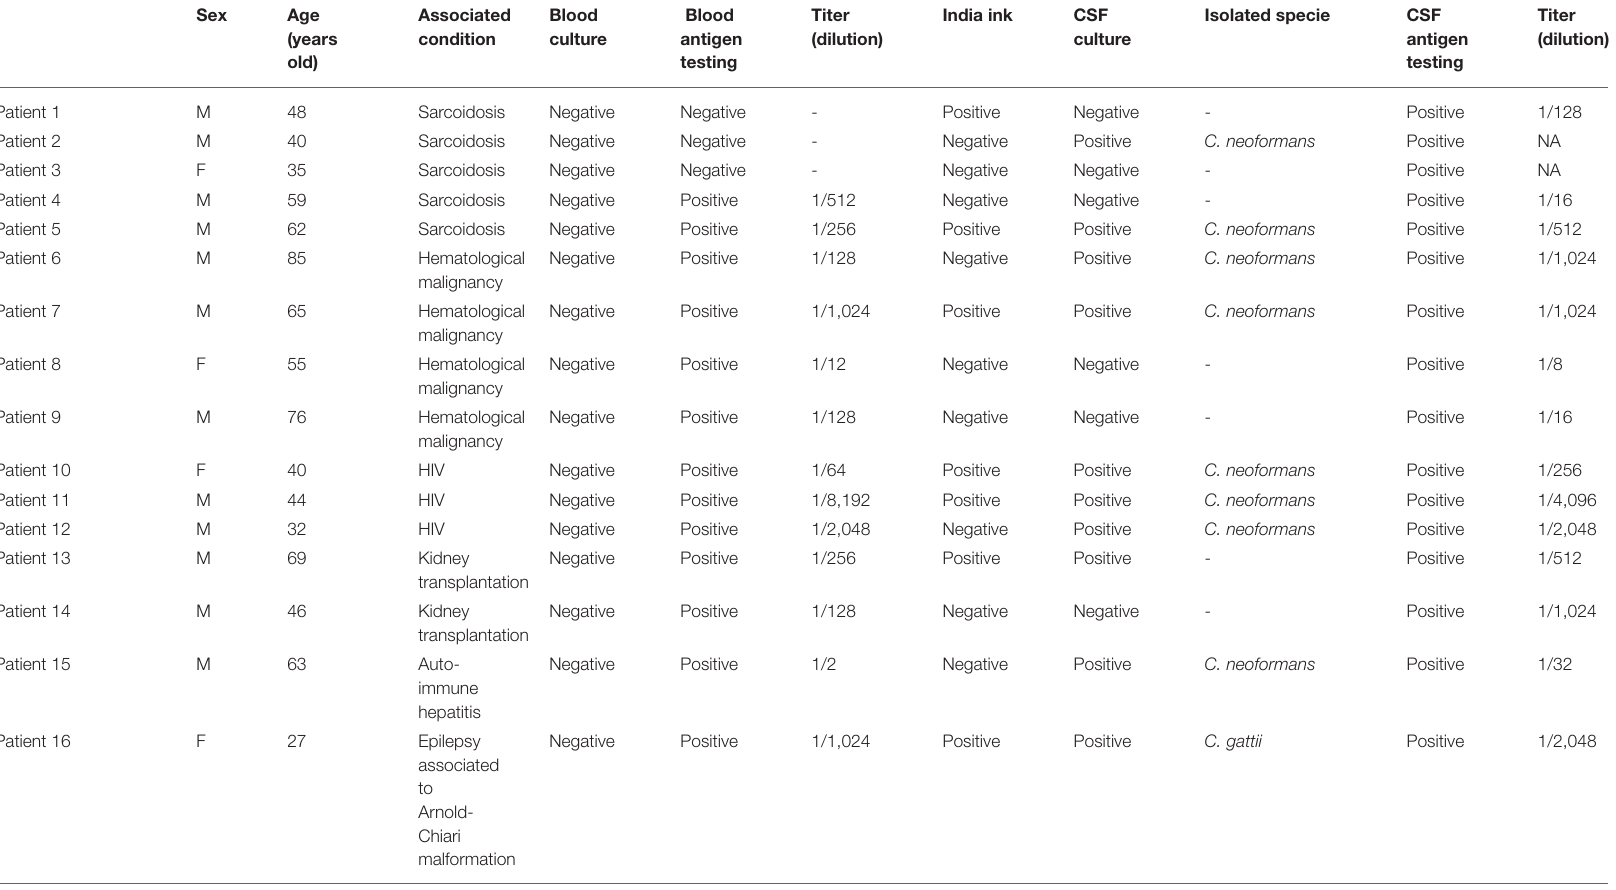
CSF, cerebrospinal fluid; HIV, human-immunodeficiency virus; F, female; M, male; NA, not